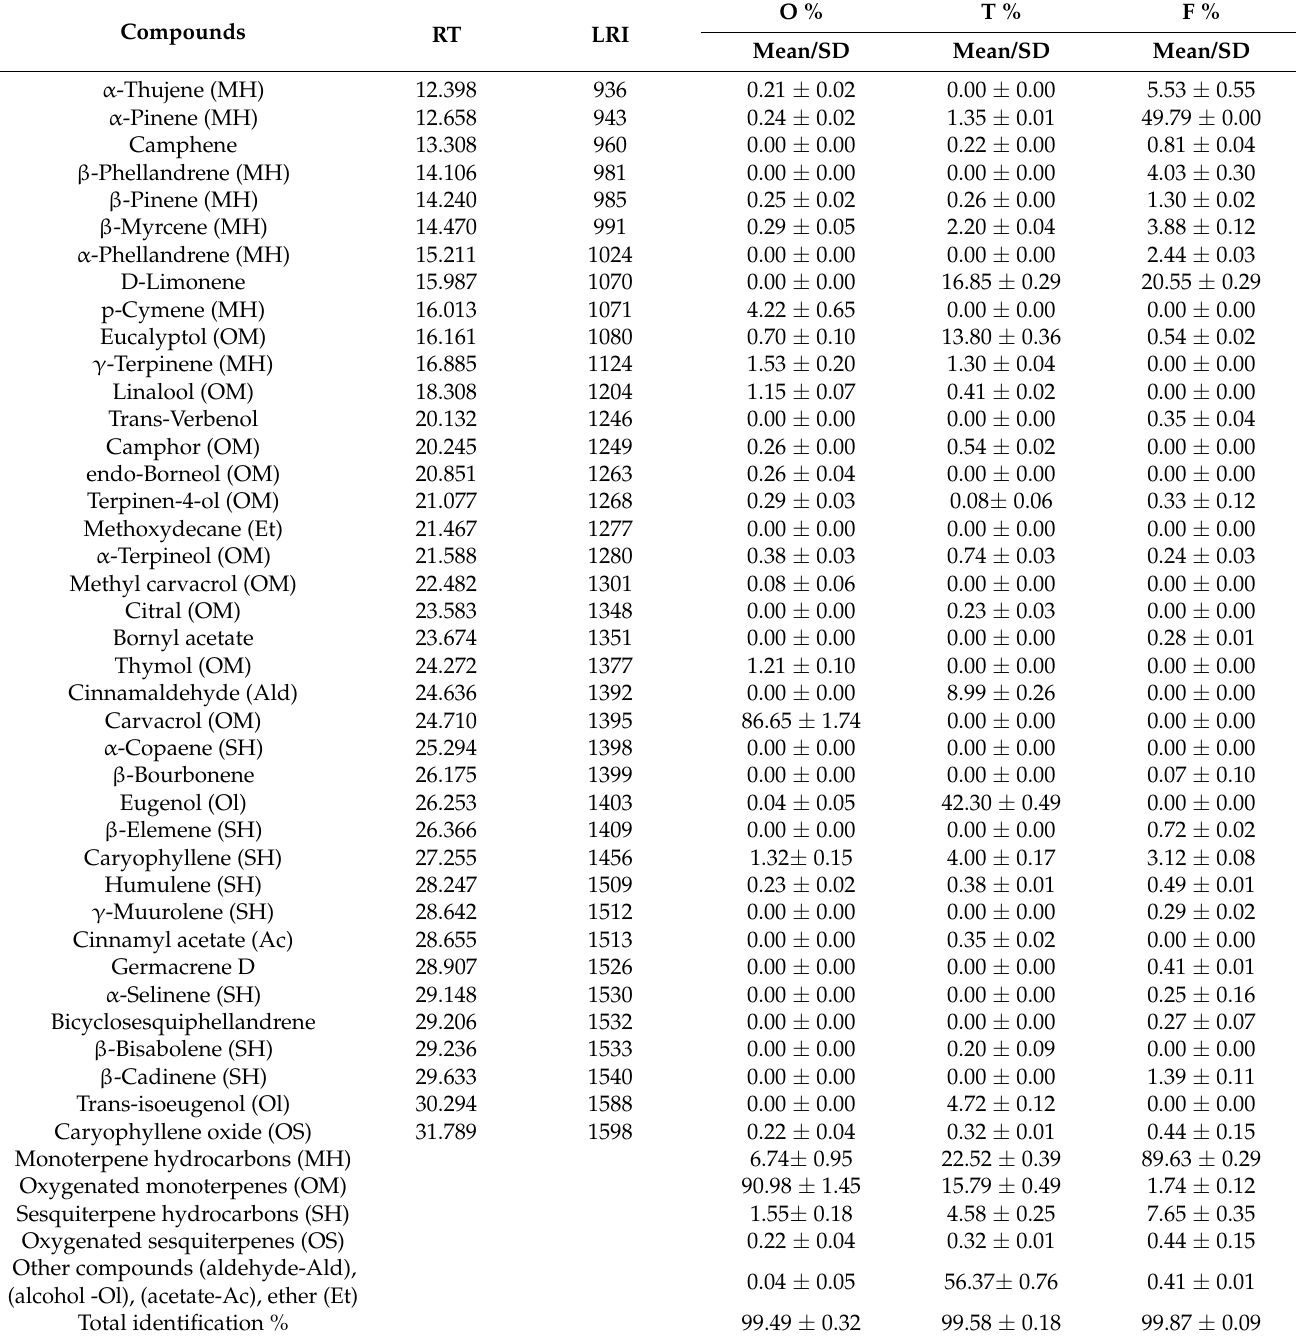
Table 1. The volatile constituents of essential